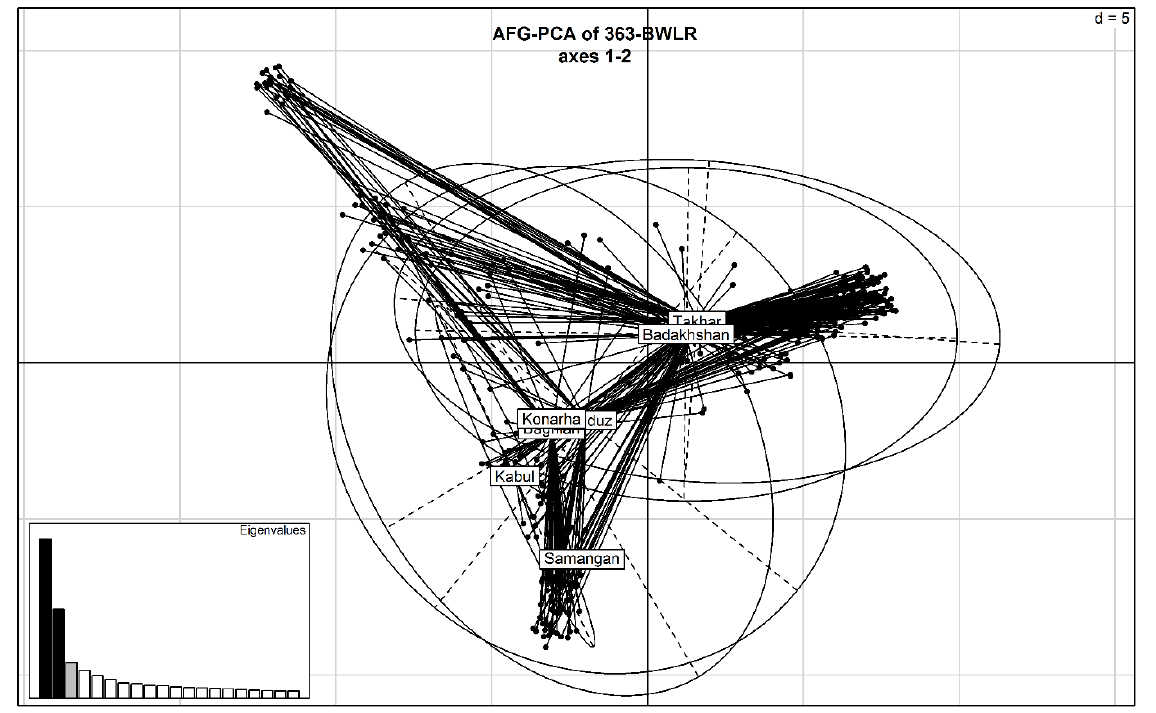
Figure 3. Principal Component Analysis of 363 Afghan bread wheat landraces. Table 3. Predictive abilities of the models for yellow (YR), leaf (LR), and stem (SR) rust adult plant resistance under field conditions using nine different methods in wheat landraces from Afghanistan preserved in ICARDA’s gene